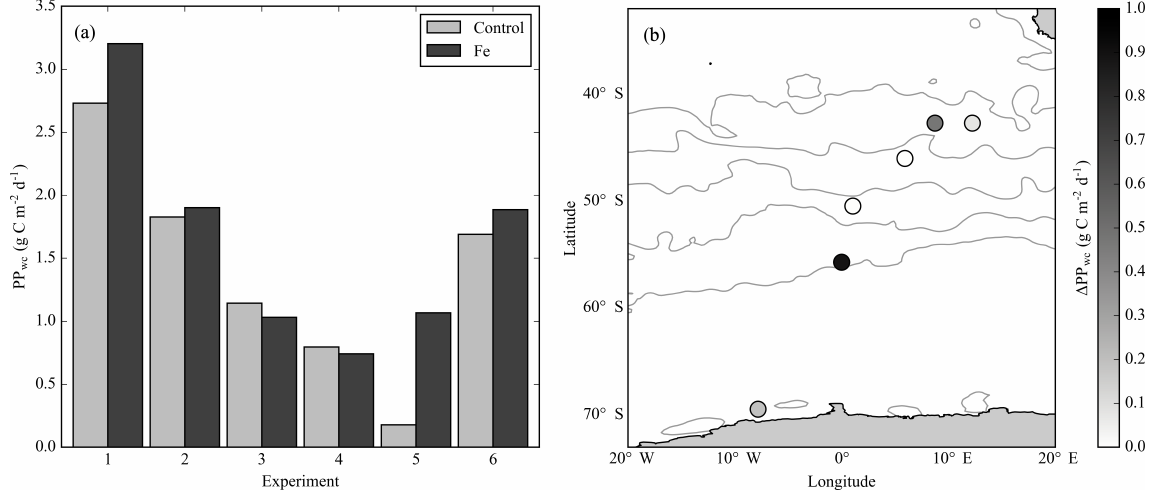
Figure 5. Modelled outputs of primary production utilizing experimentally derived photosynthetic parameters. (a) Depth-integrated primary production (PP wc ) (mgCm − 2 d − 1 ) and (b) (cid:49) PP wc (mgCm − 2 d − 1 ) . Ocean fronts, indicated by grey lines, are displayed as in Fig.